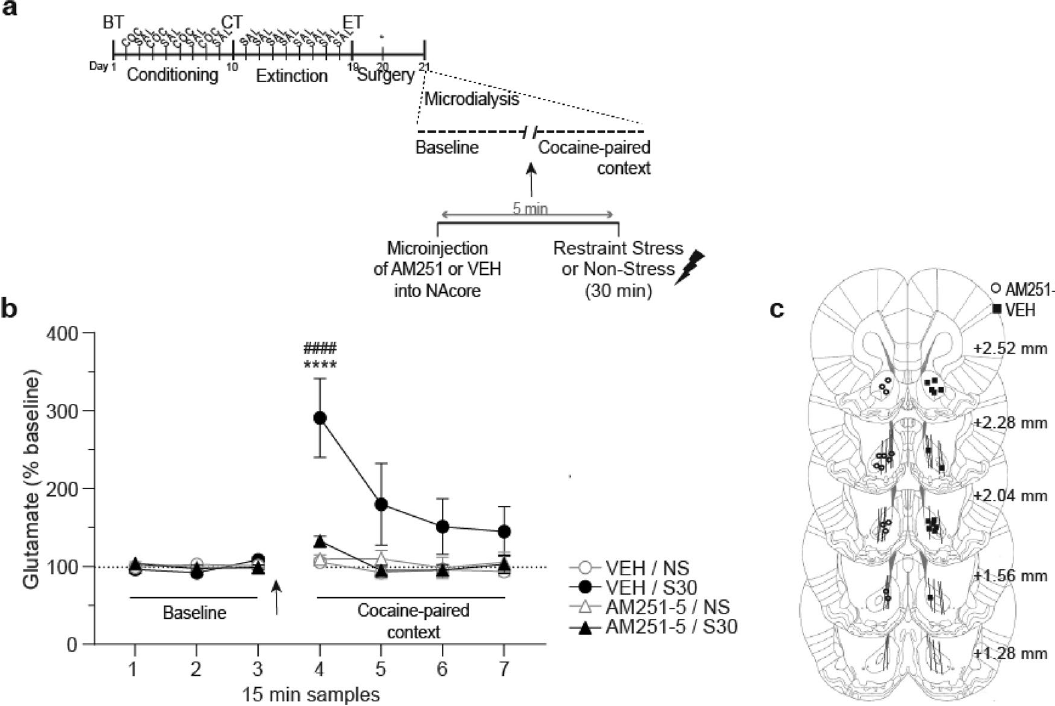
Figure 3. Stress-induced increase of extracellular glutamate was blocked by CB1R antagonism in NAcore. ( a ) Timeline of CPP procedure. Stereotaxic surgery for microdialysis probe implantation was performed once animals reached extinction criteria. The day after surgery, in vivo microdialysis was used to sample (every 15 min) extracellular glutamate in the NAcore both before (baseline determination, in home cage) and after AM251 (or VEH) intra-NAcore administration and 30 min of restraint stress (or non-stress). Following these treatments, samples were collected inside the cocaine-paired compartment of the CPP apparatus. Glutamate was quantified using EZChrom Elite software, version 4.0 (http:// www. agile nt. com). ( b ) AM251 local pretreatment attenuated the restraint stress-induced increase in glutamate of NAcore measured in the cocaine-paired context (****p < 0.0001 compared with other groups at the same time point; #### p < 0.0001 compared with the last baseline sample, using a Bonferroni’s post-hoc test). Values represent percentage of increase in glutamate release from baseline (mean ± s.e.m.) for each 15 min sample, n = 7 for each group. Arrow indicates the microinjection and restraint stress treatment. ( c ) Approximate unilateral locations of microinfusions of AM251 performed into NAcore together with the dialysis membranes placements (solid lines) of rats implanted with the dual microinjection-microdialysis probes. Numbers to the right indicate millimeters from the Bregma. Symbols represent the different microinjections